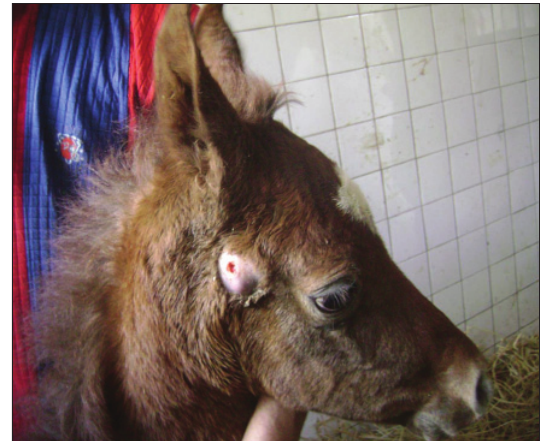
Figure-7: A foal suffering from strangles showing swollen parotid lymph node.